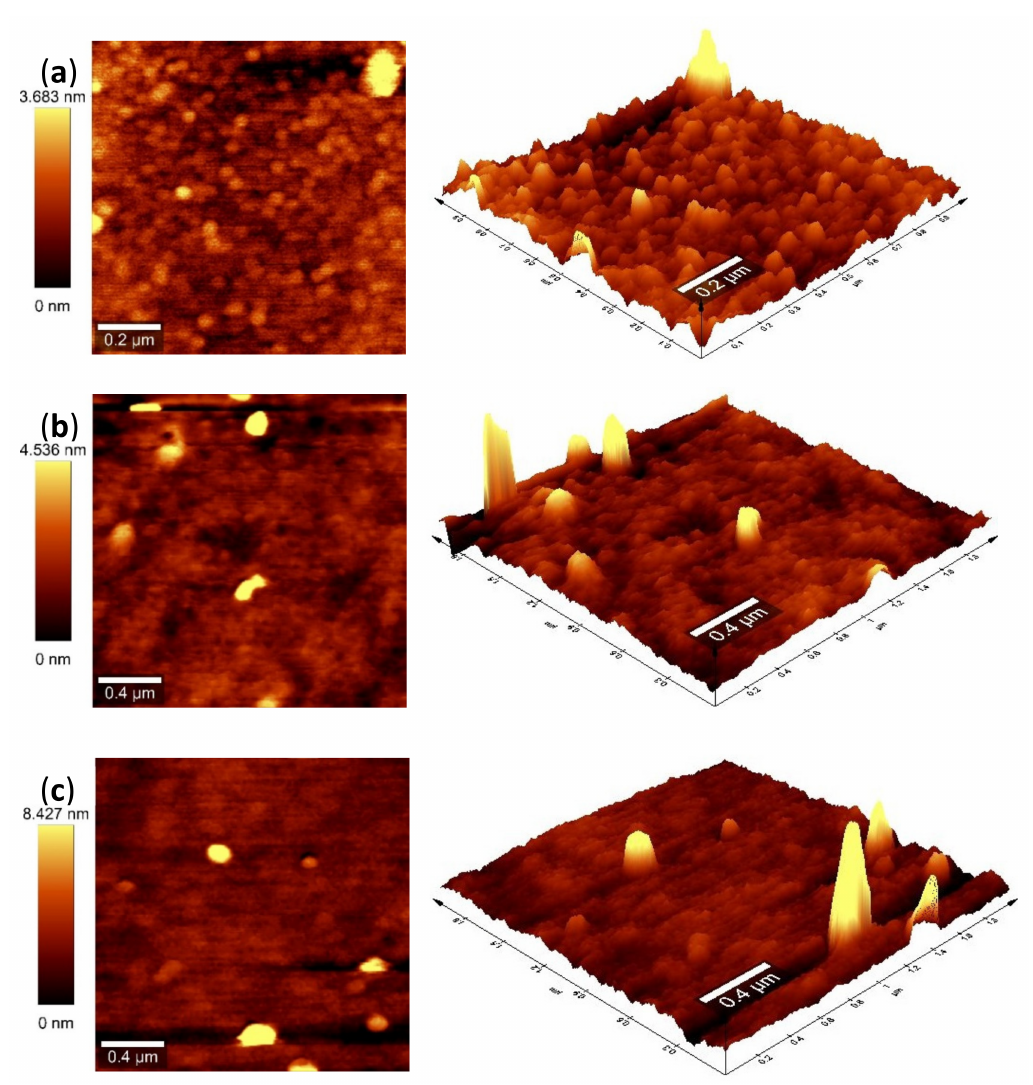
Figure 6. 2- and 3-dimensional images of TiO 2 -SiO 2 thin films with different numbers of layers. ( a ) 5TiO 2 -9SiO 2 (5 layers), ( b ) 7TiO 2 -9SiO 2 (7 layers), and ( c ) 9TiO 2 -9SiO 2 (9